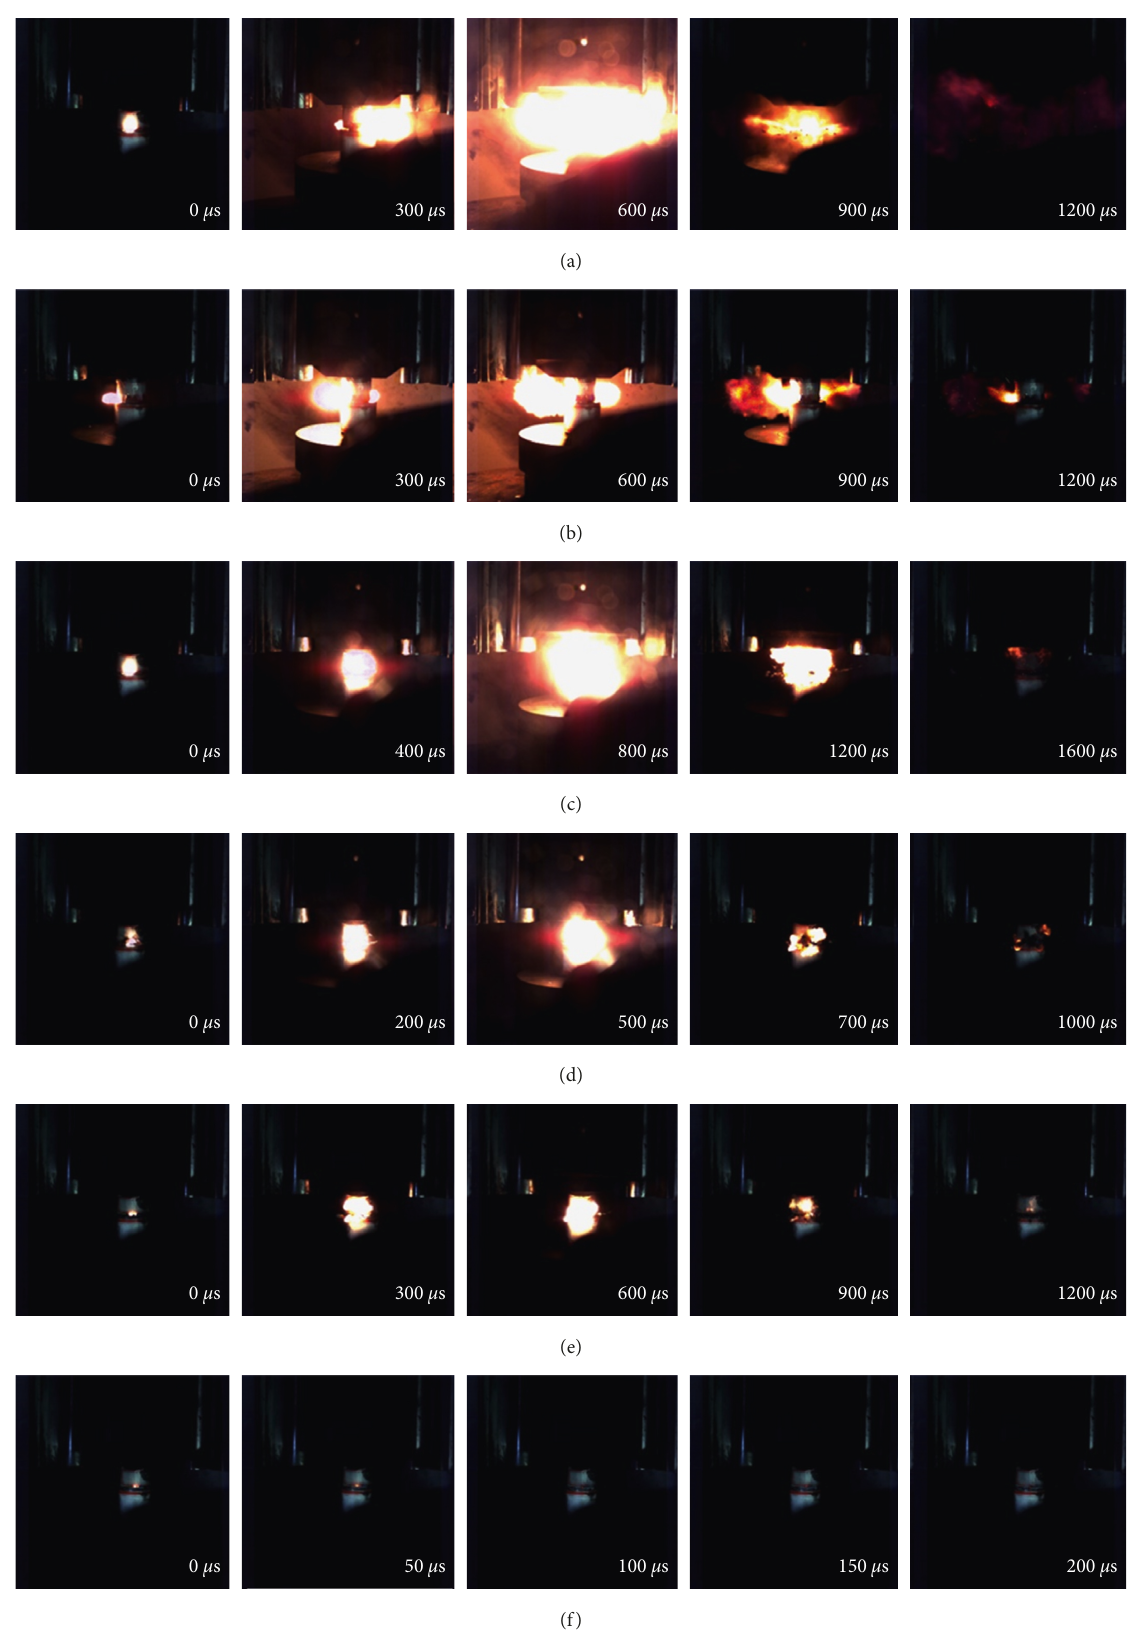
Figure 8: The reaction process of specimens #1–#6 under drop hammer impact. (a) Specimen #1. (b) Specimen #2. (c) Specimen #3. (d) Specimen #4. (e) Specimen #5. (f) Specimen